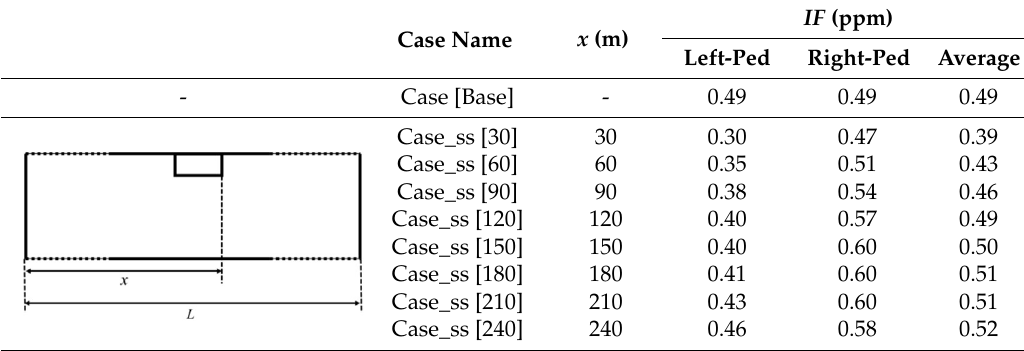
Table 5. Intake Fraction ( IF ) in cases with a single short catcher above the left-pedestrian side.